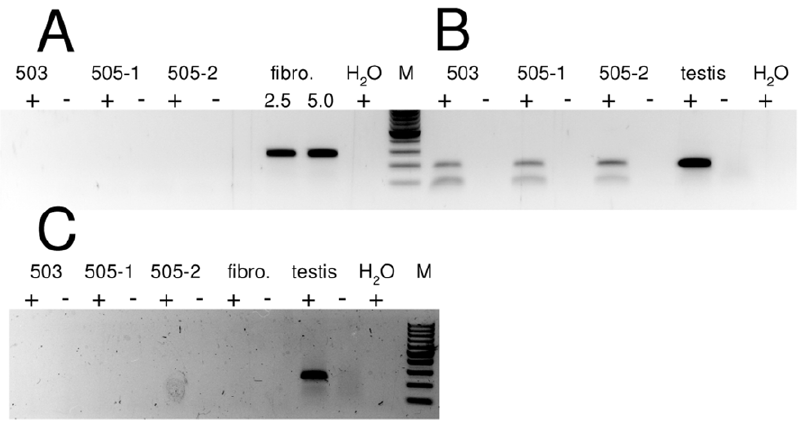
Figure 2. Absence of Venus transcripts in spermatozoa-specific RNA. A) Absence of Venus mRNA in boar spermatozoa; Venus -specific RT- PCR from the indicated sperm samples of boars # 503 and # 505, fibroblast ( # 505) and no template. For fibroblasts ( # 505) samples 2.5 and 5 ng of cDNAs, for the spermatozoa samples 60 ng of cDNAs were used as templates. From # 505 ejaculates, two independent RNA-isolations were assayed. B) The sperm-specific Protamine 1 transcripts are detectable in all isolations of sperm-specific RNA: protamine1 ( PRM1 )-specific RT-PCR from the indicated sperm samples of boars # 503 and # 505, and testis (wt). + , with RT; - without RT; H 2 O, no template. From # 505 ejaculates, two independent RNA-isolations were assayed. C) The hematopoietic-specific marker CD45 is expressed only in testis, but not in fibroblasts or Percoll purified spermatozoa. 503, 505-1, 505-2: indicate different RNA-preparations of spermatozoa from transposon-transgenic boars; fibro, testis indicate RNA preparations from transgenic fibroblasts and wildtype testis; + , - indicate the addition, or omission of RT; H 2 O is the no template control.